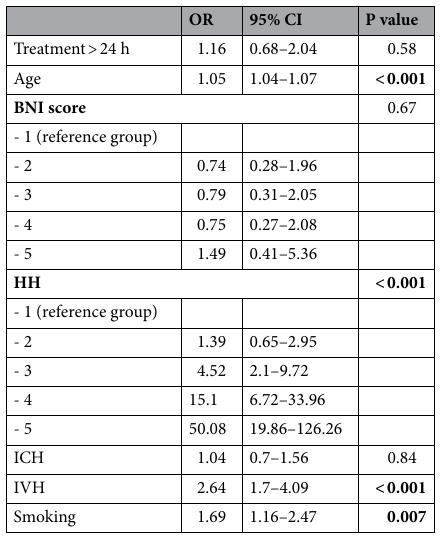
Table 6. Multivariable analysis dichotomized GOS at discharge. BNI Barrow Neurological Institute, HH Hunt and Hess, ICH intracerebral haemorrhage, IVH intraventricular